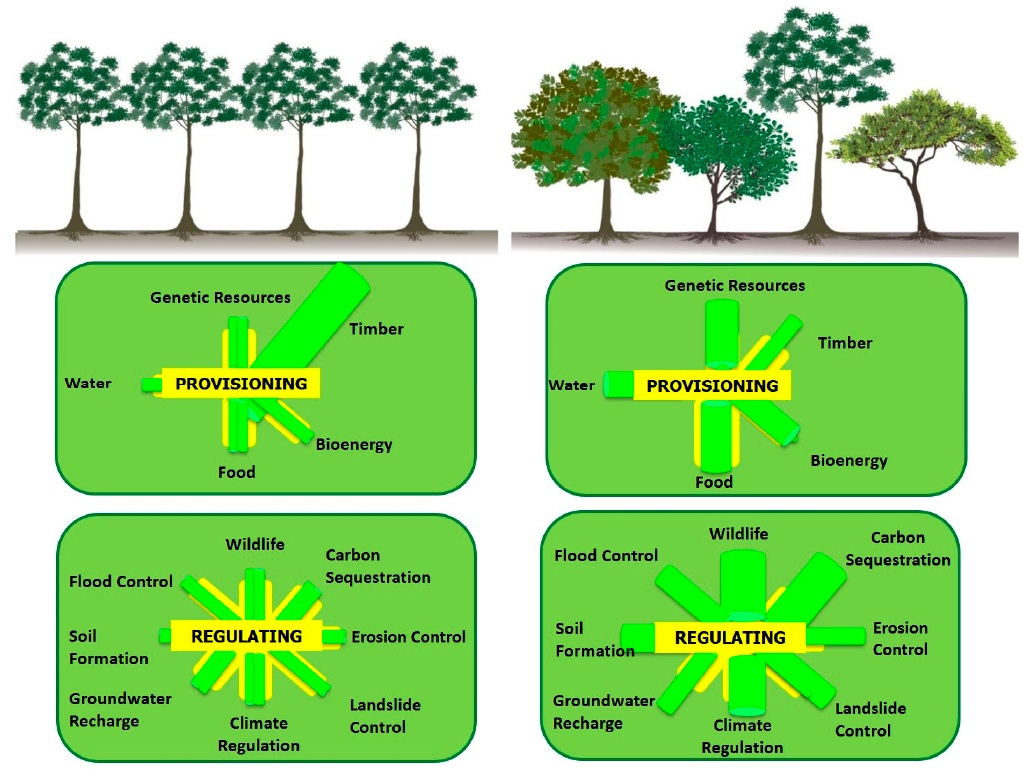
Figure 1. Differences in provisioning and regulating ecosystem services delivery in monospecific and mixed forests plantations. Interdependent relationships in planted forests limit the delivery (length and wide of green bars) of several good or services if emphasis is given to a sole objective. Forests 2017 , 8 , 489